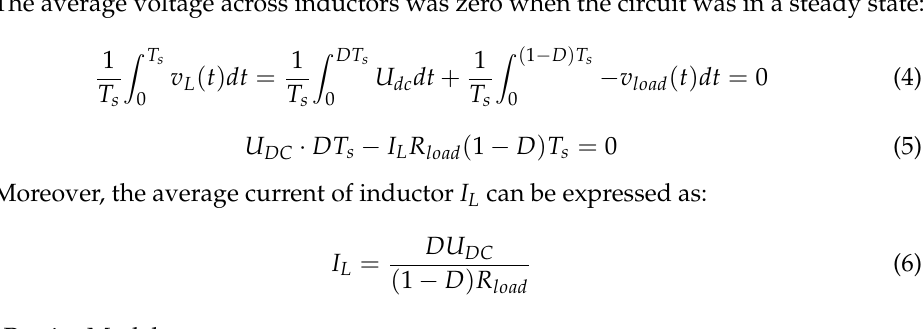
Figure 8. Inverter topology transformation among different stages: ( a ) the charging stage; ( b ) posi- tive pulse; ( c ) negative pulse; ( d ) deadtime.